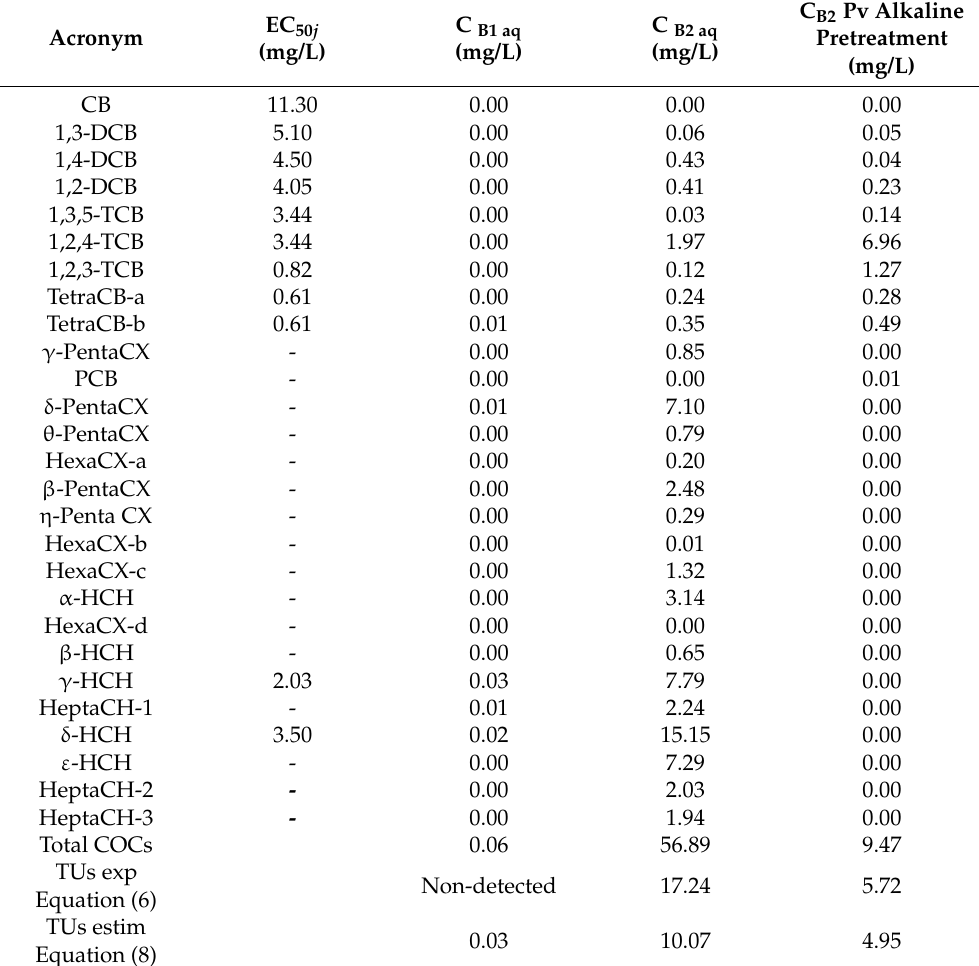
Table 2. Composition and toxicity of the aqueous elutriates obtained at neutral conditions from = 2 L soils B1 and B2 ( V L ) and alkaline conditions in soil B2 ( V L W kg concentration of identified COCs is also